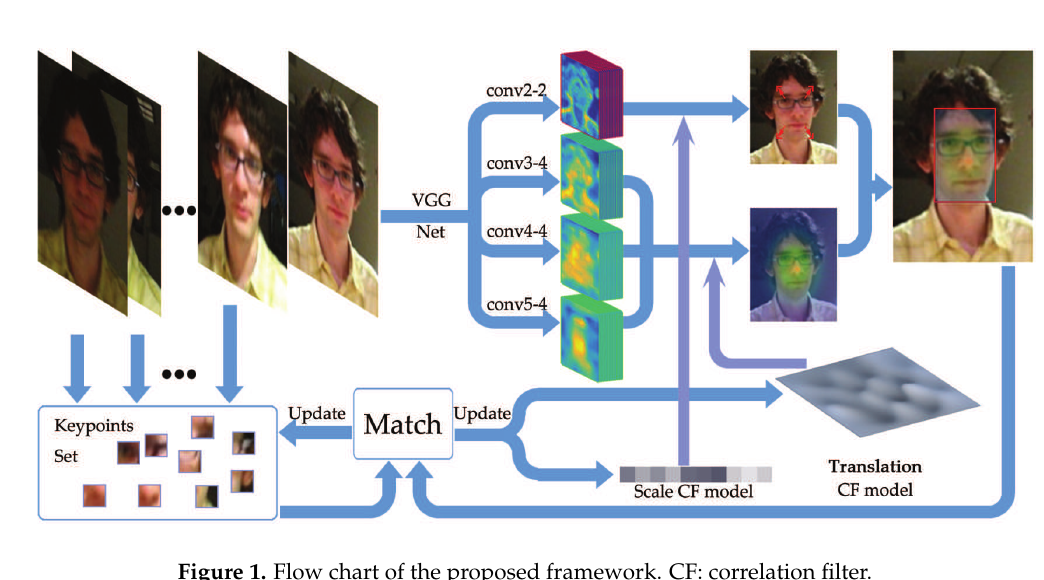
Figure 1. Flow chart of the proposed framework. CF: correlation